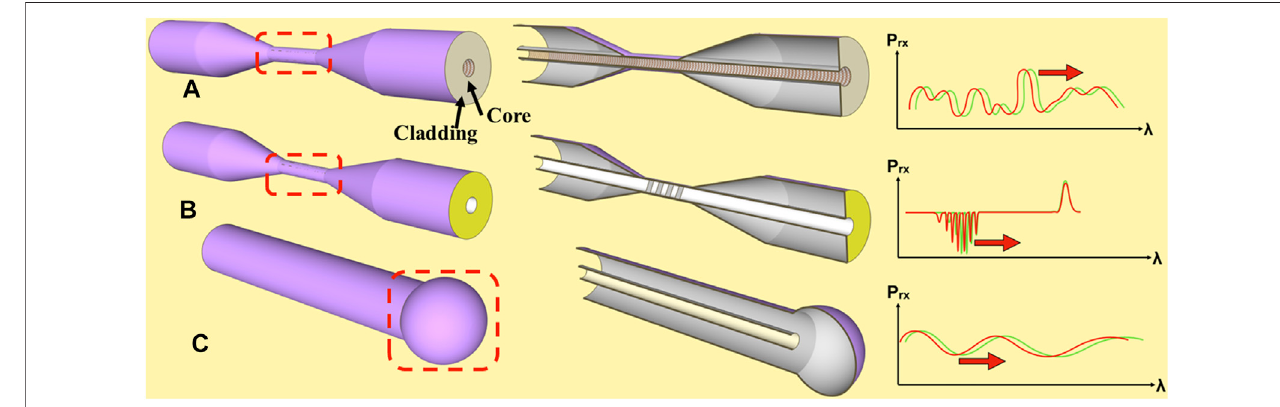
FIGURE 2 | Schematic diagram of optical fi ber based biosensors. (A) MgO nanoparticle doped- fi ber, (B) eTFBG and (C) ball resonator, each biosensor has its corresponding cross section (middle) and the respective spectrum (right). Highlighted in red (dotted rectangle) is the sensing region.